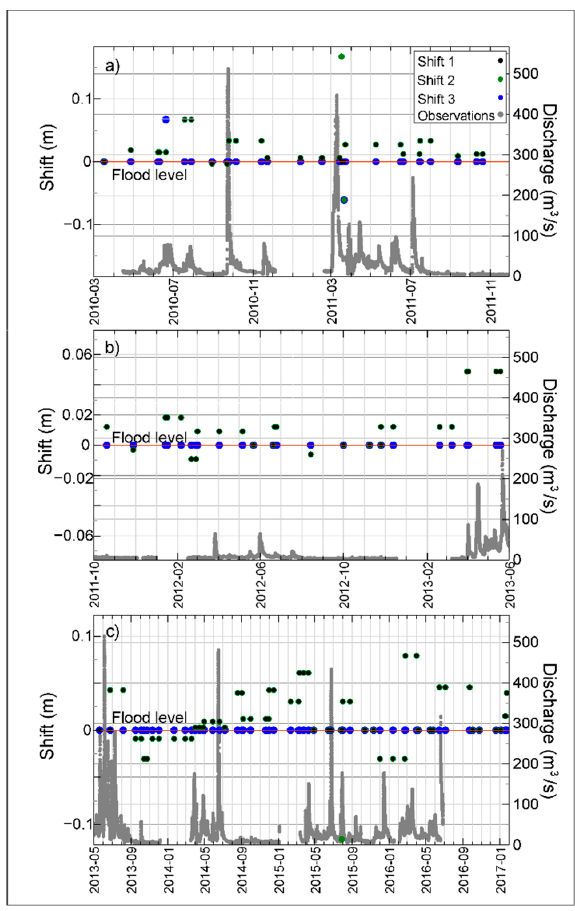
Figure 9. Shift values plotted with hydrograph data in Cedar River at Osage. Black, green, and blue dots represent the shift values applied to the section, channel, and overbank control areas, respectively. ( a ) Hydrograph for base rating curve #1.0; ( b ) hydrograph for base rating curve #1.1; and ( c ) hydrograph for base rating curve #1.2.